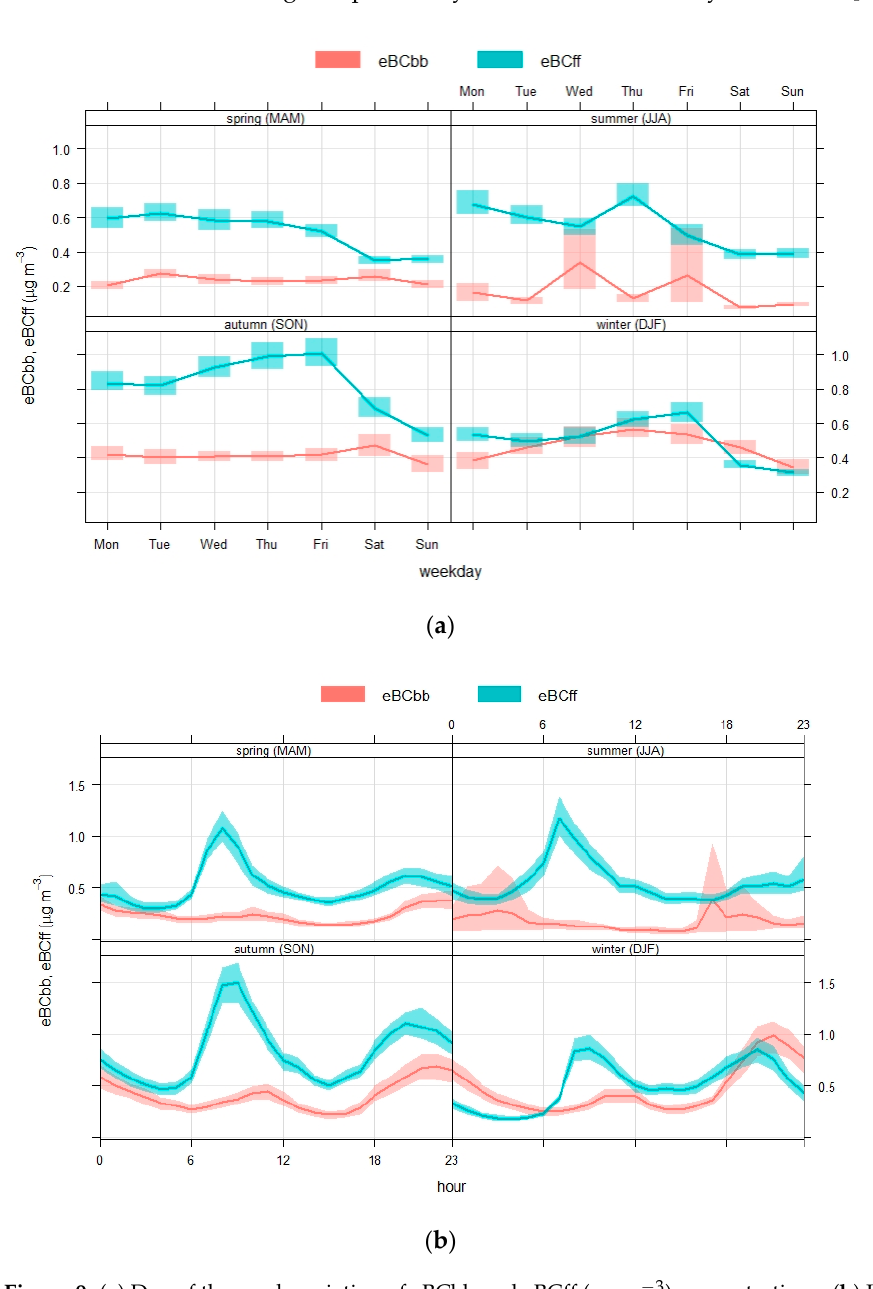
Figure 9. ( a ) Day of the week variation of eBCbb and eBCff (µg m − 3 ) concentrations. ( b ) Hour of day variation of eBCbb and eBCff (µg m − 3 ) concentrations. Shaded area represents the range of values in which 95% of sample means lie.